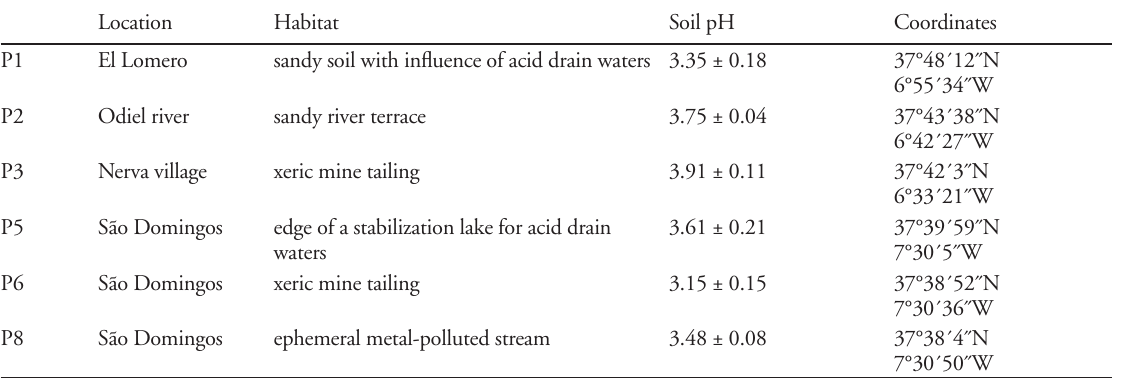
Table 1. A brief description of the sampled populations.